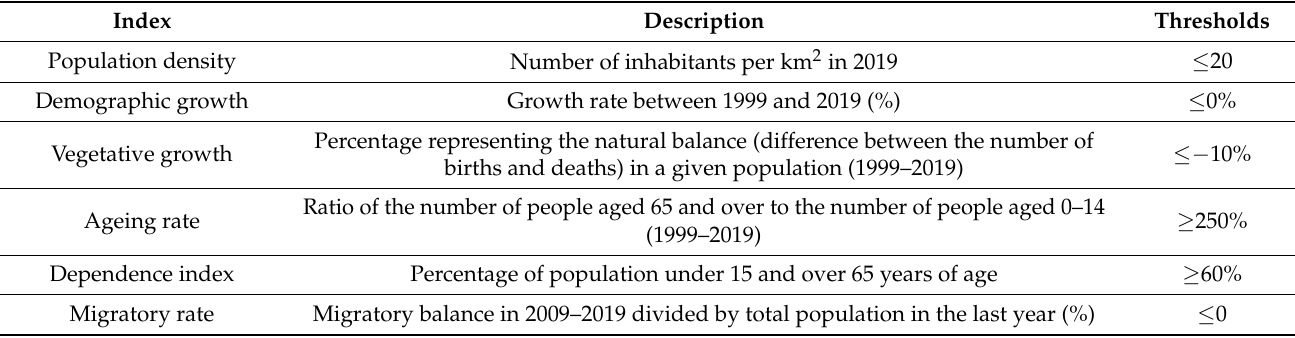
Table 4. Municipal depopulation indicators and